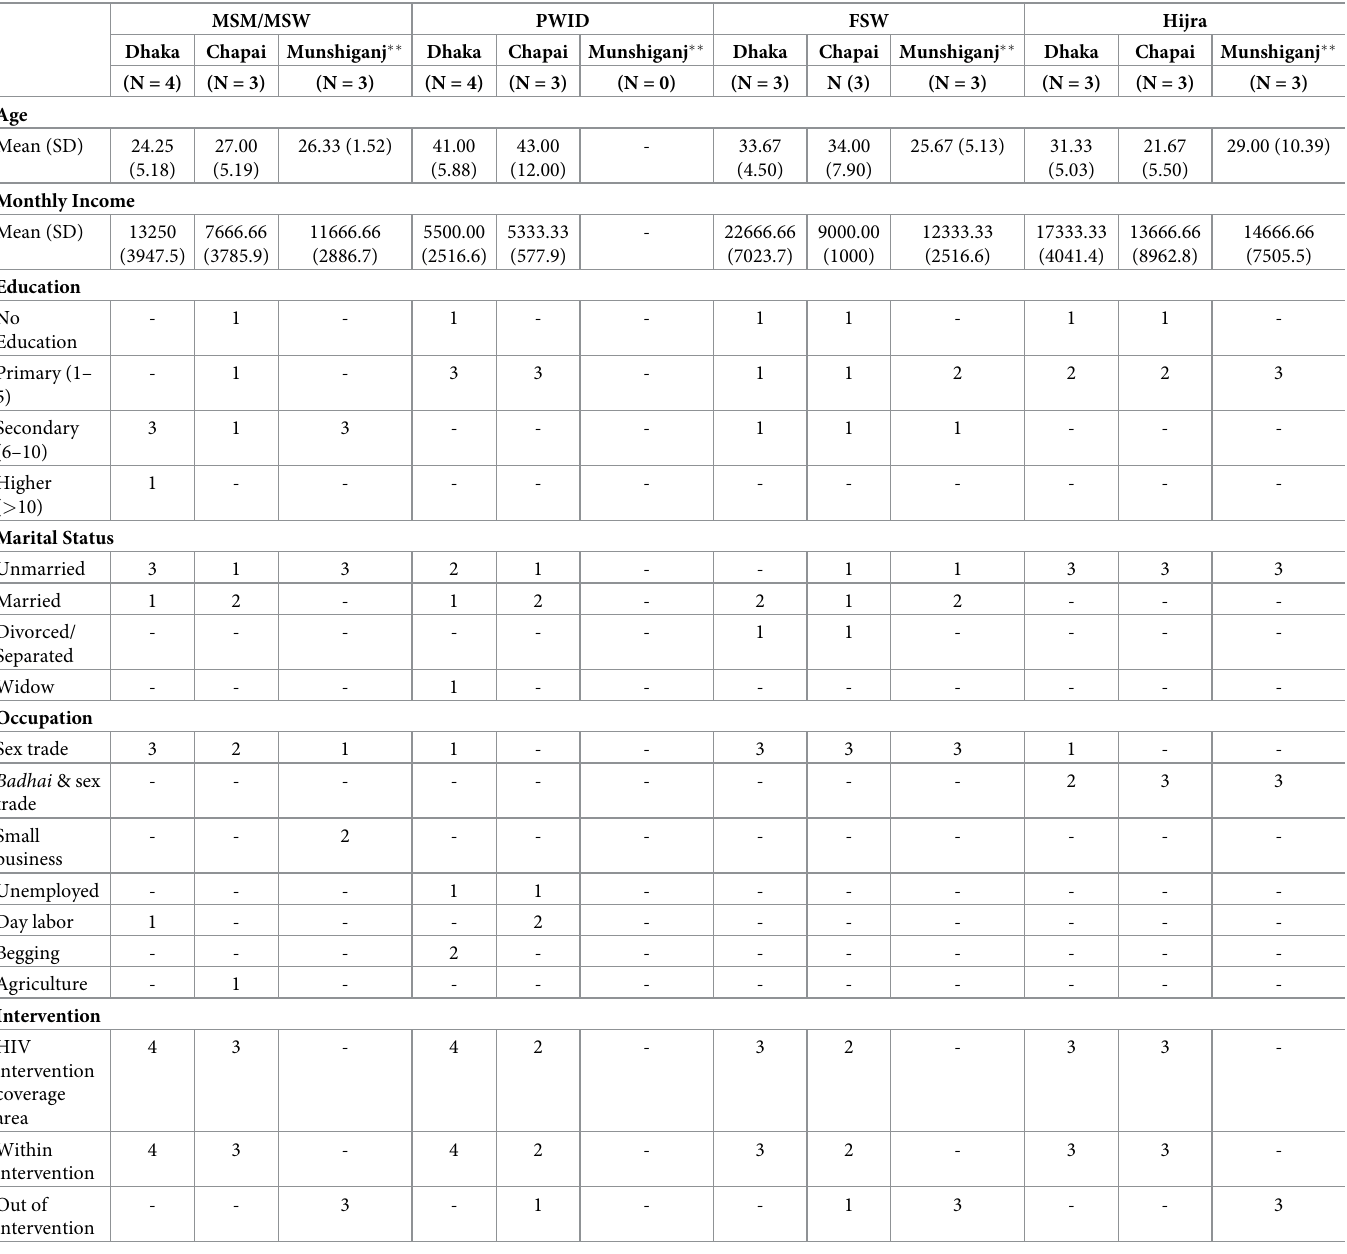
Table 1. Socio-demographic status of the 34 KPs participating in the in-depth